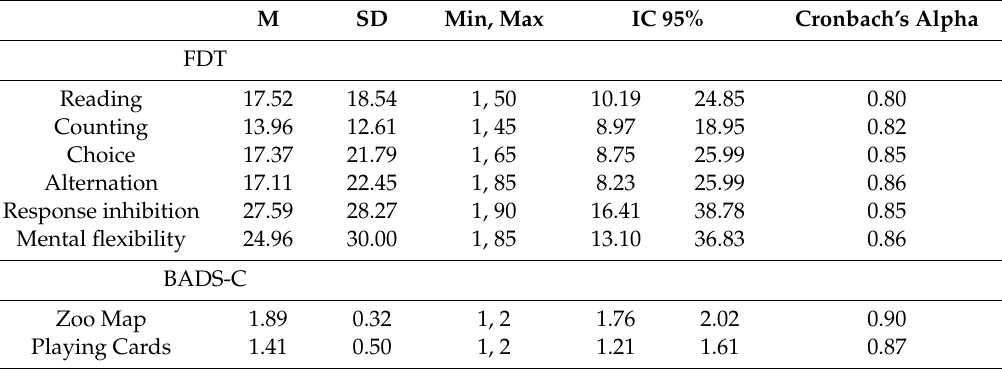
Table 1. Means and standard deviations of the five digit test (FDT) and behavioural assessment of the dysexecutive syndrome in children